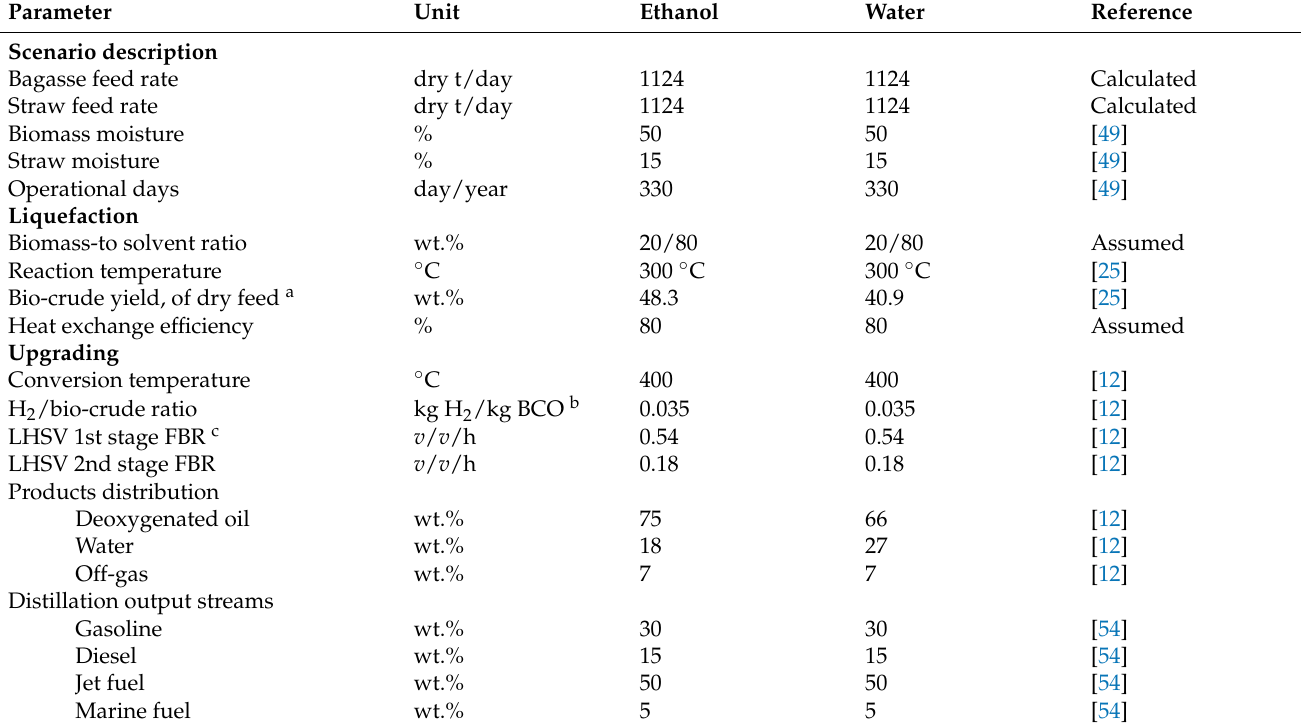
Table 2. Main parameters adopted for the HTL